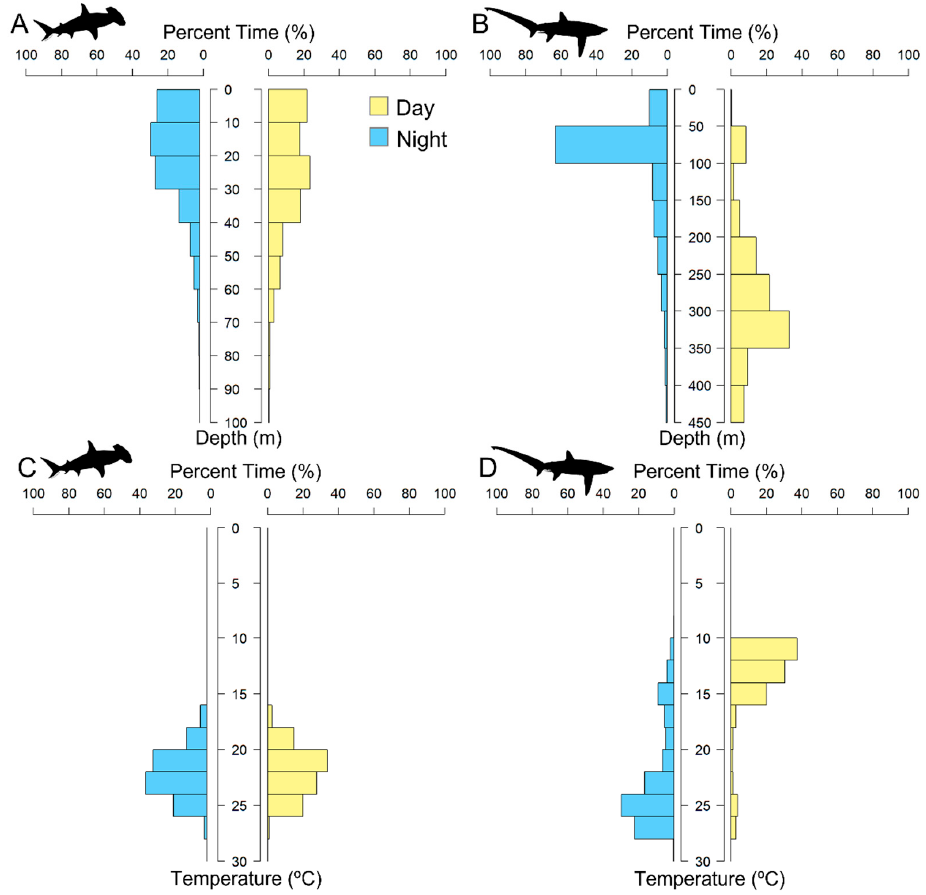
Figure 3. Time-at-depth for the ( A ) scalloped hammerhead shark, categorized into 10 m intervals, and the ( B ) bigeye thresher shark, categorized into 50 m intervals. Time-at-temperature for the ( C ) scalloped hammerhead shark and ( D ) bigeye thresher shark, categorized into 5 °C intervals.